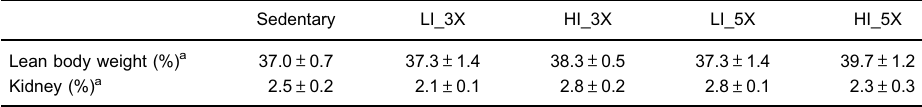
Table 2. Relative lean body weight and kidney weight after 96 h of cisplatin